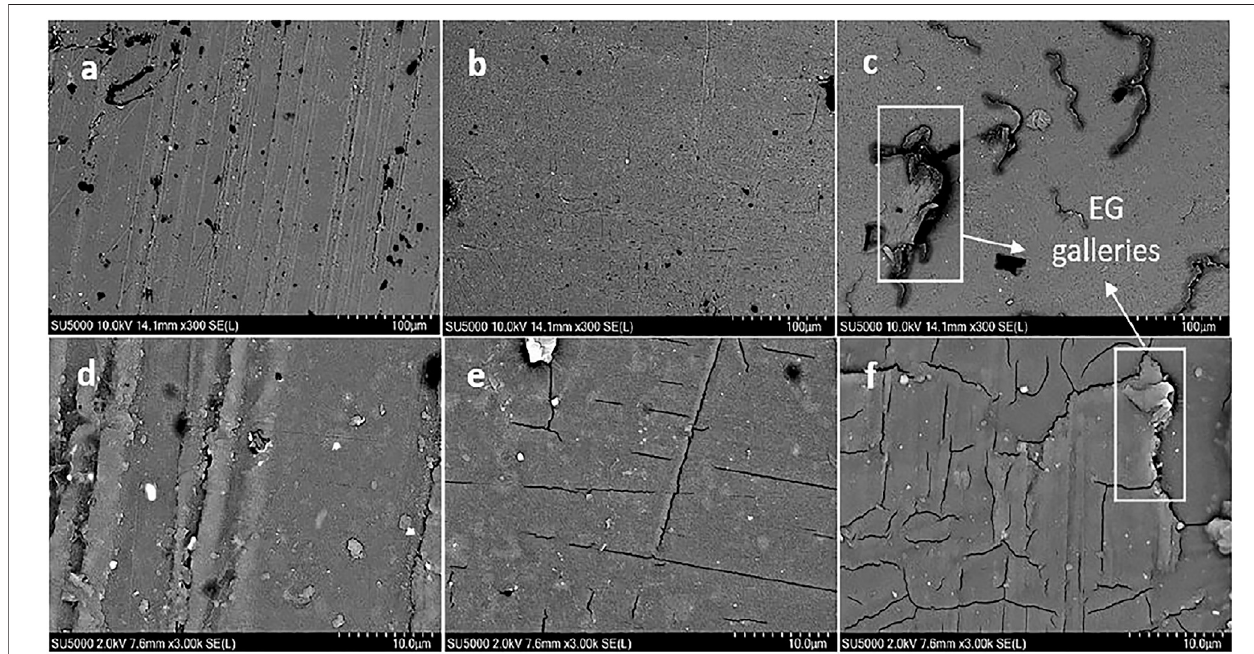
FIGURE7| Lowandhighmagni fi cationSEMimages oftheworn surfaces oftheneatPEEK (A,D) andthePEEK/EG composites containing3 (B,E) and7 (C,F) vol % EG.